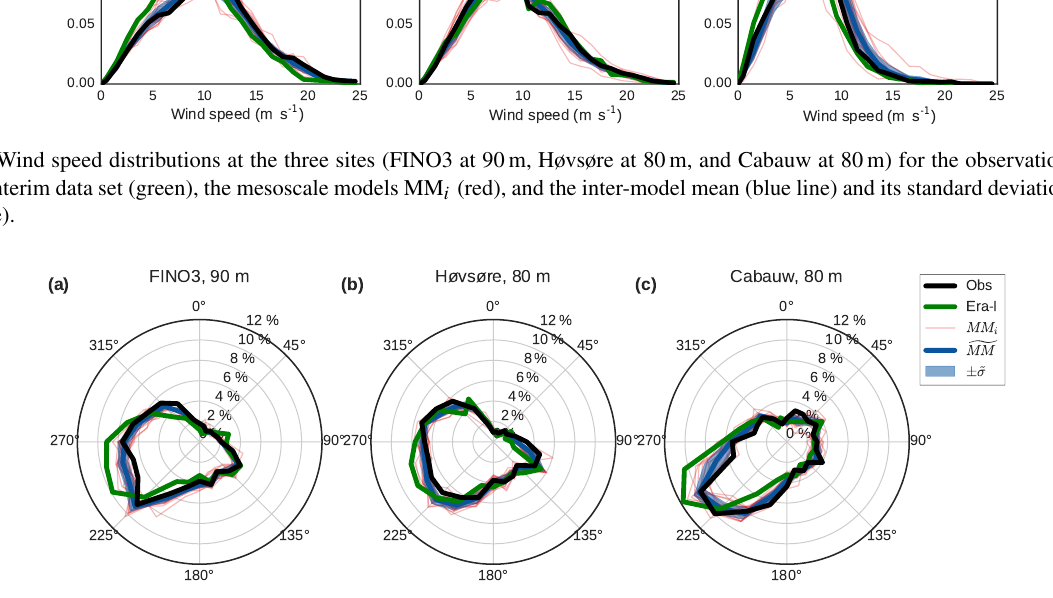
Figure 5. Wind direction distributions at the three sites (FINO3 at 90m, Høvsøre at 80m, and Cabauw at 80m), based on 24 sectors, for the observations (black), the ERA-Interim data set (green), the mesoscale models MM i (red), and the inter-model mean g MM (blue line) and its standard deviation ± e σ (blue